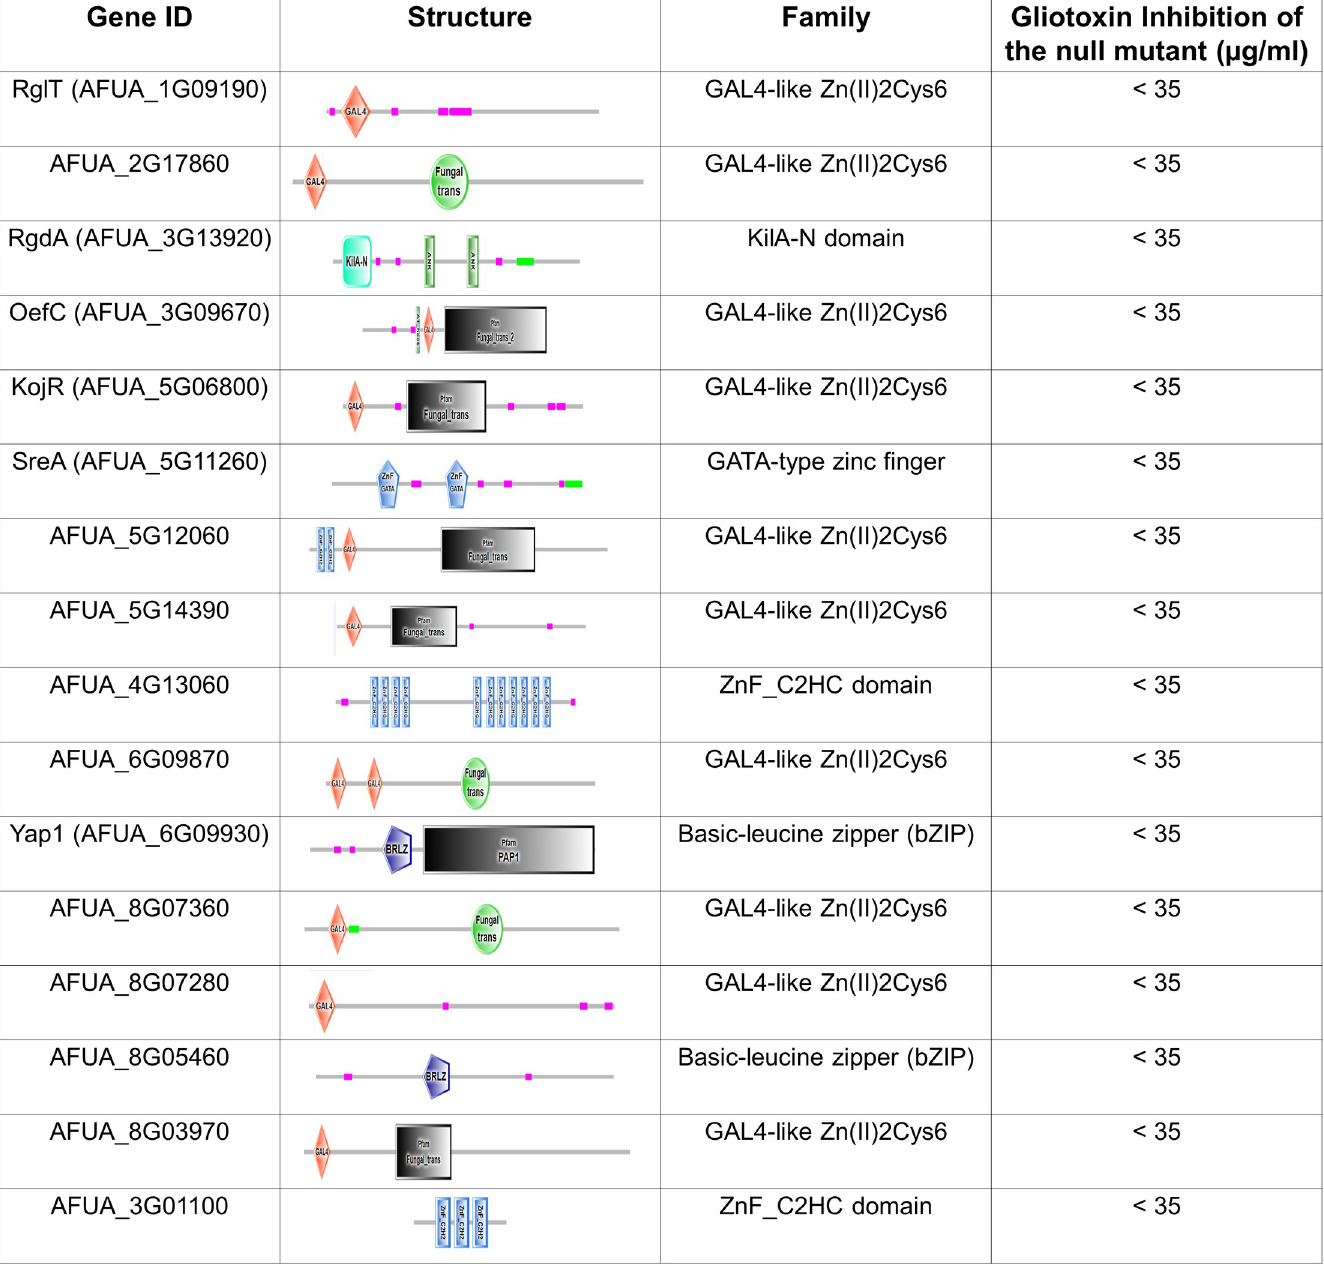
Fig 4. List of the transcription factor mutants identified as more sensitive to gliotoxin (the domais organization are based on http://smart.embl-heidelberg.de/).